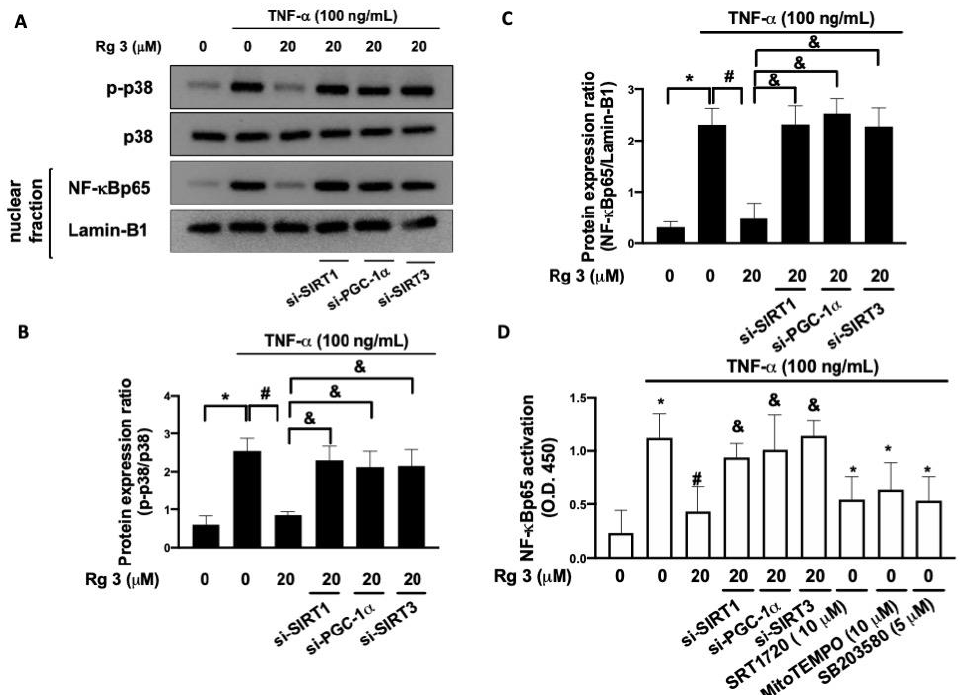
Figure 5. Rg3 mitigates TNF- α -caused NF-kB activation. Representative Western blot images ( A ) and relative densitometric bar graphs of p-p38/p38 ( B ) and NF-kBp65/Lamin-1 ( C ) in chondrocytes stimulated to 100 ng/mL TNF-a for 24 h were shown. In some cases, cells were transfected with siRNAs 48 h before treatment with Rg3. NF-kB activation was also confirmed by the NF- α B activity kit ( D ). In some cases, cells were transfected with siRNAs 48 hrs before treatment with Rg3. The selective activator SIRT1, SRT1720, and the inhibitor of mitochondrial ROS, mitoTEMPO, and the inhibitor of MAPK p38, S203580, were pre-treated 2 h before TNF- α stimulation. (* indicating p < 0.05 compared with the control group; # indicating p < 0.05 compared to TNF- α -stimulated cells; & indicating p < 0.05 compared to TNF- α plus Rg3 cells).